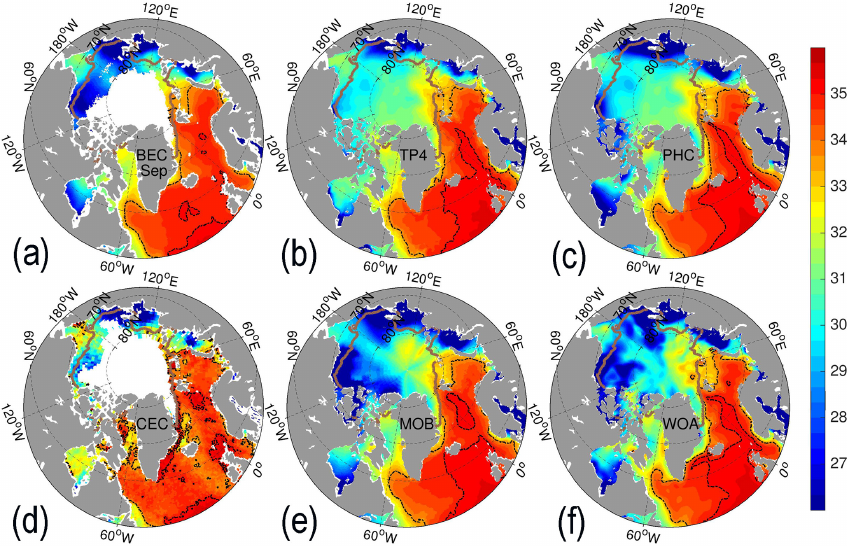
Figure 3. Similar to previous figure but for